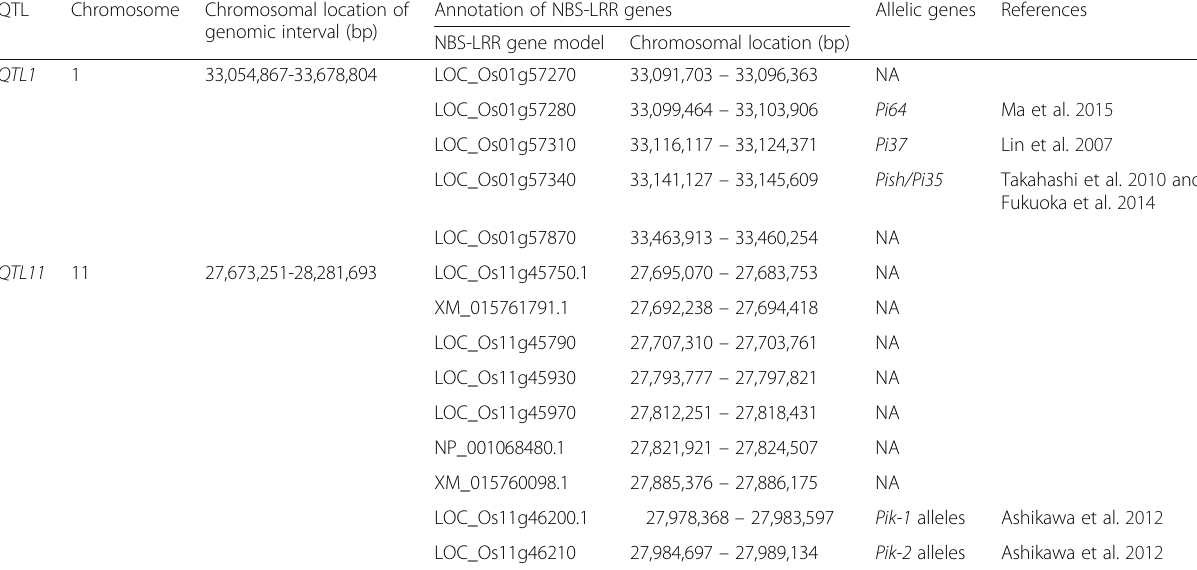
Table 2 Gene annotation of NBS-LRR gene which located in the genomic intervals of QTL1 and QTL11 of JHN using Nipponbare reference sequence QTL